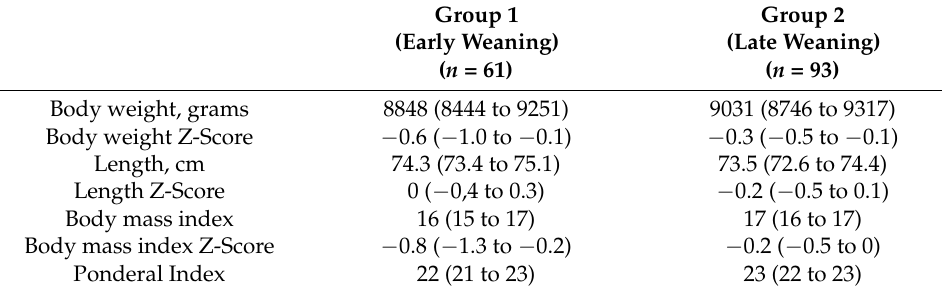
Table 4. Growth parameters at 12 months of corrected age.